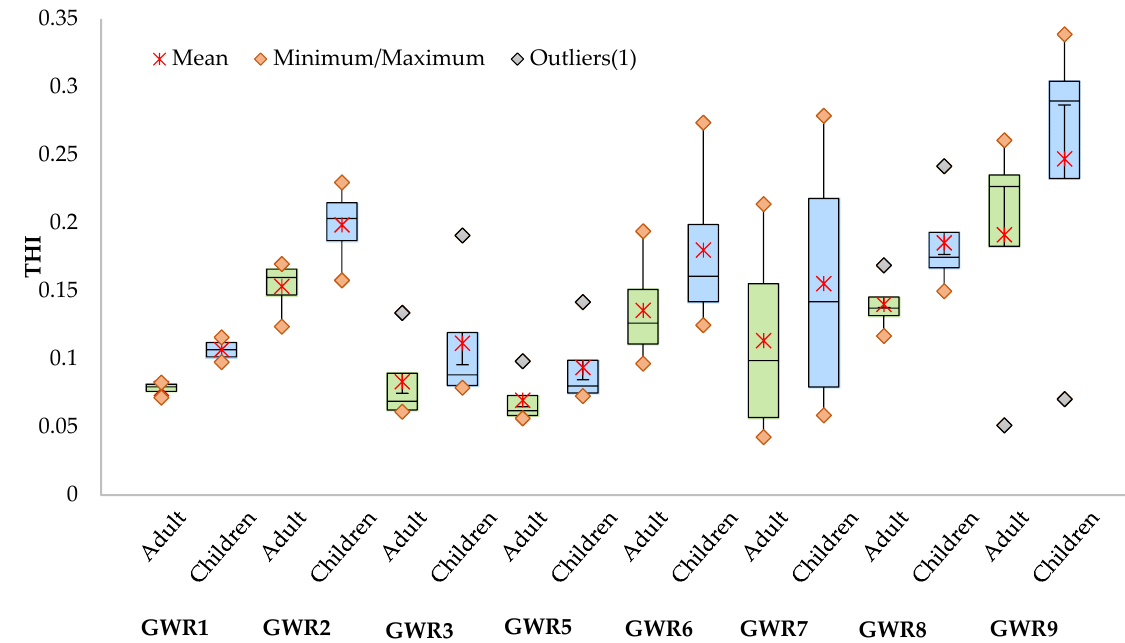
Figure 5. Seasonal variation of total hazard index (THI) for adults and children through dermal and oral exposure to uncontrolled quality spring waters in the studied area.